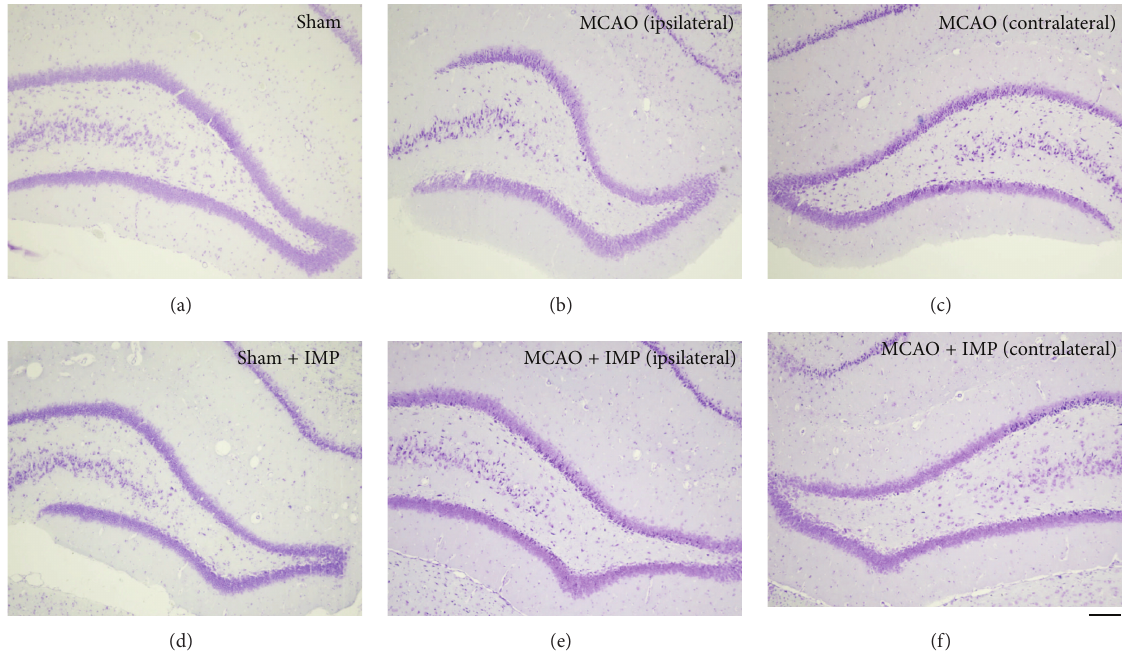
Figure 2: Typical images of the cresyl violet staining in the hippocampal dentate gyrus of rats. Note that the entire shape of GCL in (b) (ipsilateral MCAO) is shrunk compared to the others. Scale bar indicates 200 𝜇